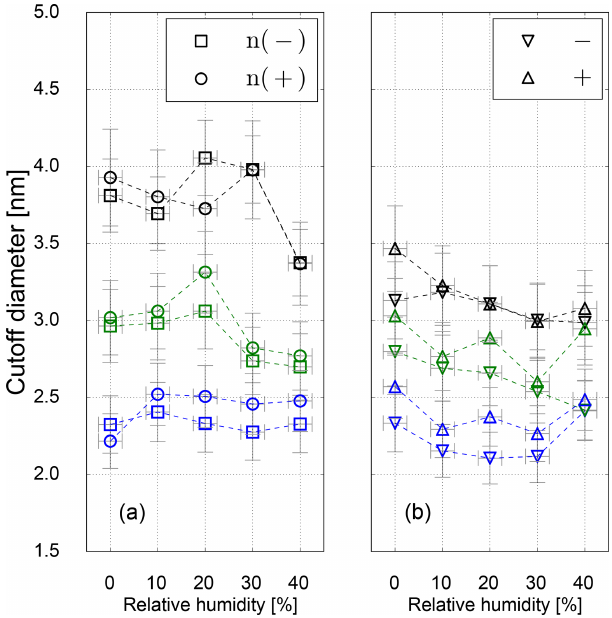
Figure 7. Cutoff diameter as a function of RH for neutral (a) and charged (b) Ag seeds for low- (blue), standard- (green) and high- temperature (black)